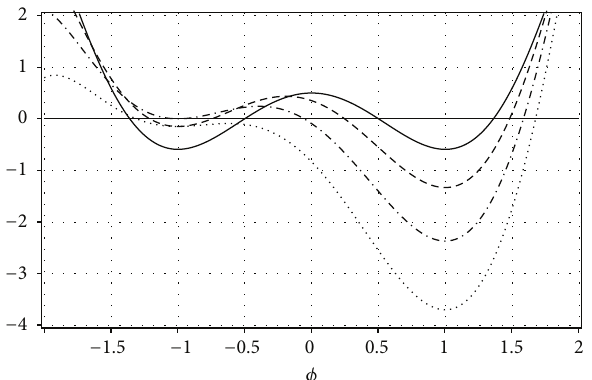
Figure 2: The warp factor 𝑒 2𝐴 with 𝐴 given by (11) for 𝑐 = 0 (solid line), 𝑐 = 2/3 (dashed line), 𝑐 = 4/3 (dot-dashed line), and 𝑐 = 2 (dotted line). We fix 𝐴(0) = 0 .